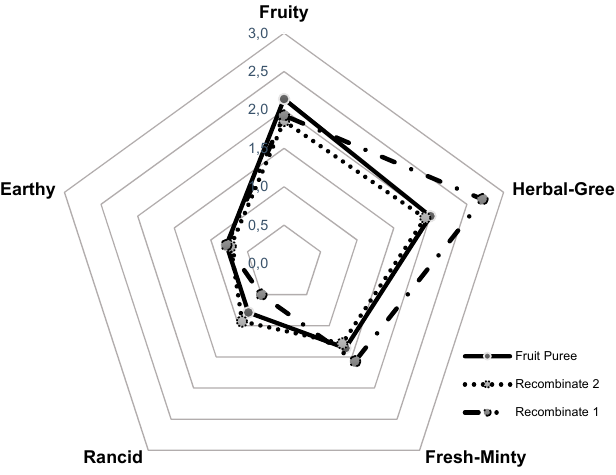
Figure 3. Aroma sensory profile comparison of yellow tamarillo fruit and recombinated mixtures.